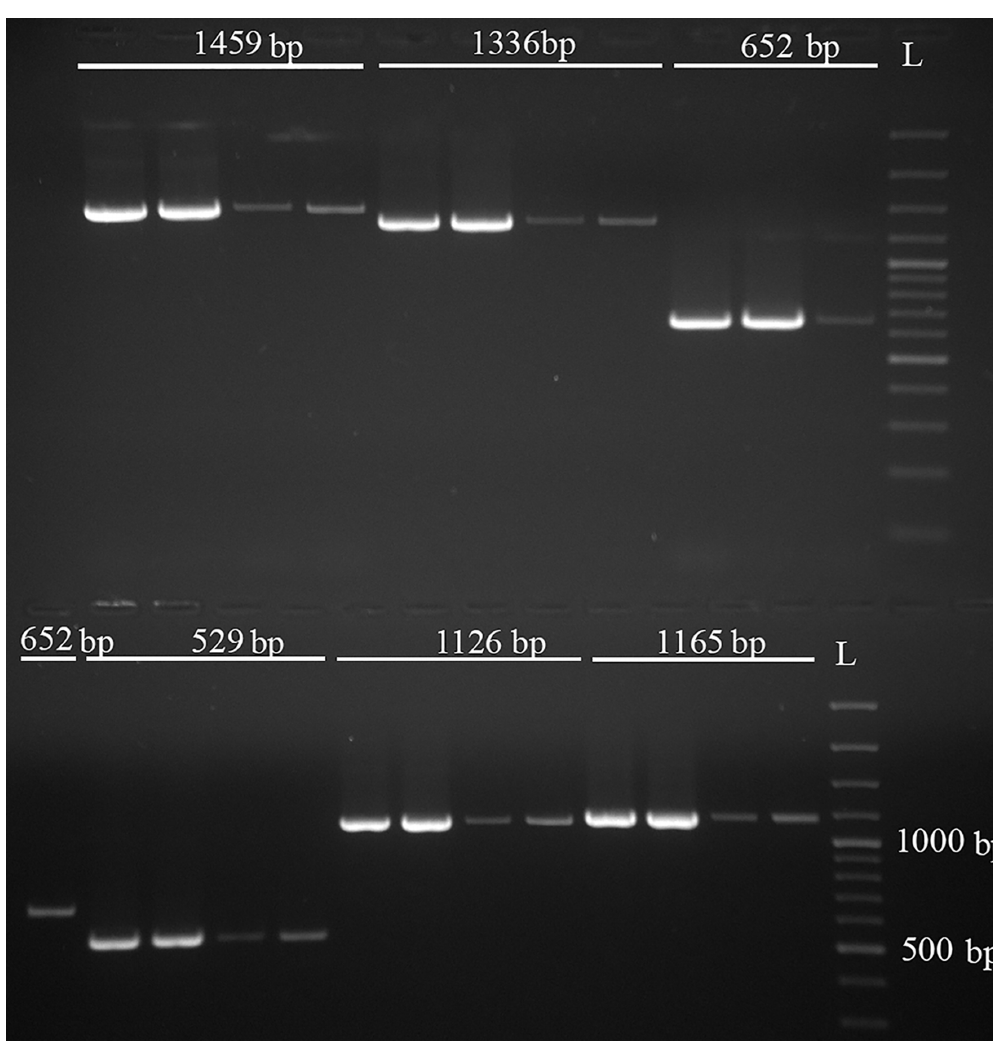
Fig 4. Electrophoretic scan of six PCR products of different lengths. +B/0B quantitative discrepancy, the first two templates +B and the second two templates 0Bs. L- GeneRuler 100 bp DNA Ladder Plus (Thermo